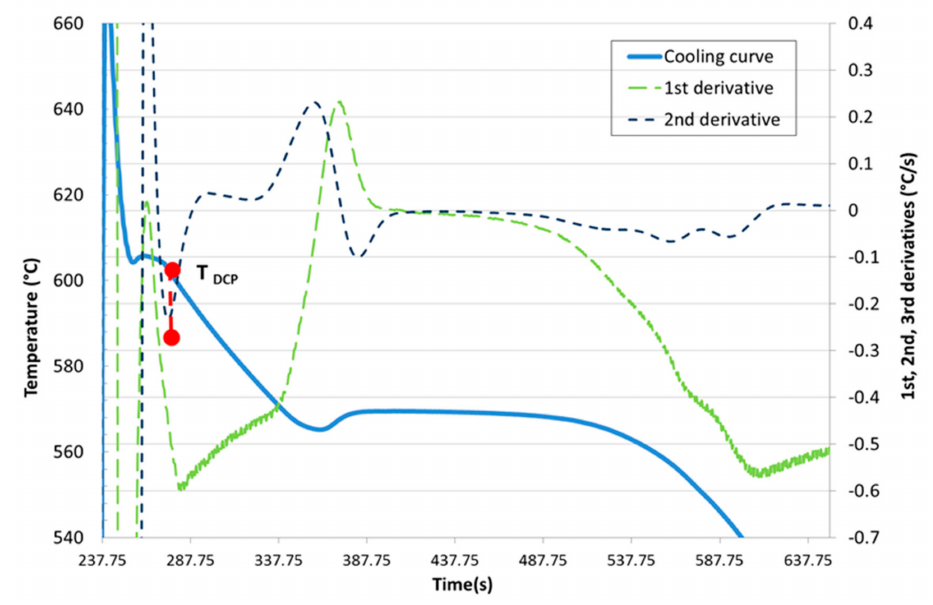
Figure 1. Method 1: the first minimum of the d 2 T/dt 2 curve.